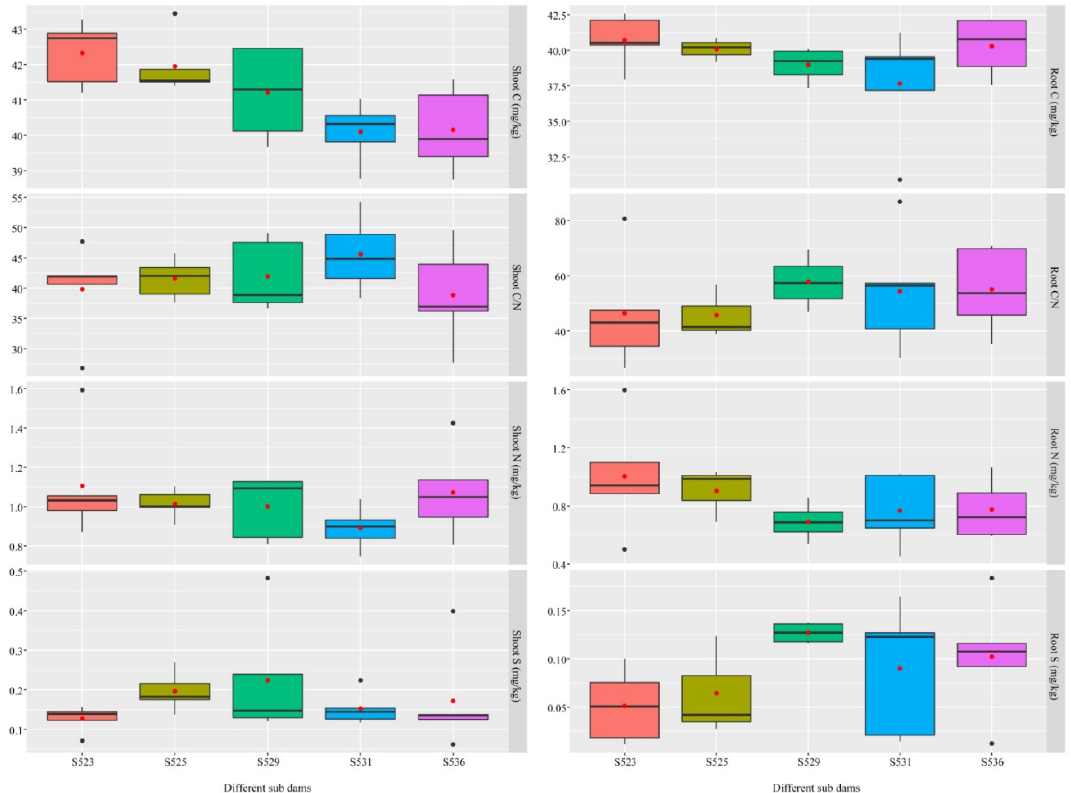
Figure 1. Total nitrogen (N), total carbon (C), ratio of carbon and nitrogen (C/N), and total sulphur (S) in shoot and root of B. ischaemum . Different-colored boxes represent different sub-dams (red, S523, olivine, S525, green, S529, blue, S531, pink, S536).